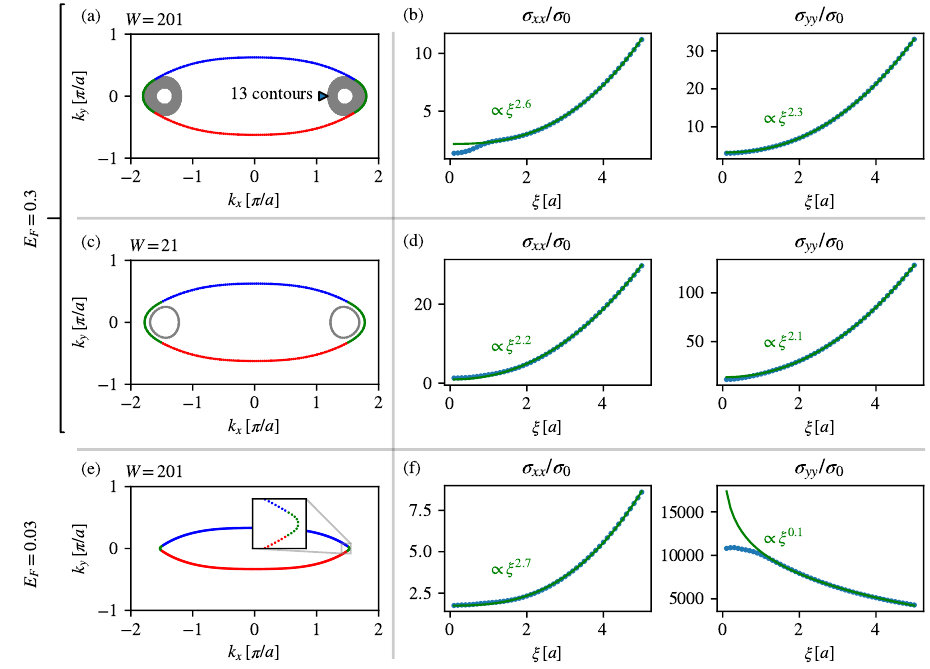
Figure 4: Impurity-range dependence of the conductivity. (a),(c),(e): Discretized = 0.3 t , W = 201), Fermi-level contours for the three parameter choices ( E F = 0.3 t , W = 21), and ( E = 0.03 t , W = 201). The number of finite-size ( E F F + N induced states (surface states and chiral bulk states), N , relative to the total s c + N ) / N = 0.14, (c) ( N + N ) / N = 0.68, and (e) number of states N is (a) ( N s c s c ( N + N ) / N = 1. Color indicates surface states at the upper (blue) and lower (red) s c surfaces, bulk states (gray), and the chiral bulk states (green), cf. Fig. 2. (b), (d), (f): Conductivity as a function of the impurity width ξ . The green curves show power-law = 0.3 t fits, the exponent is indicated in the plot. Other parameters are β = 1.5, µ b